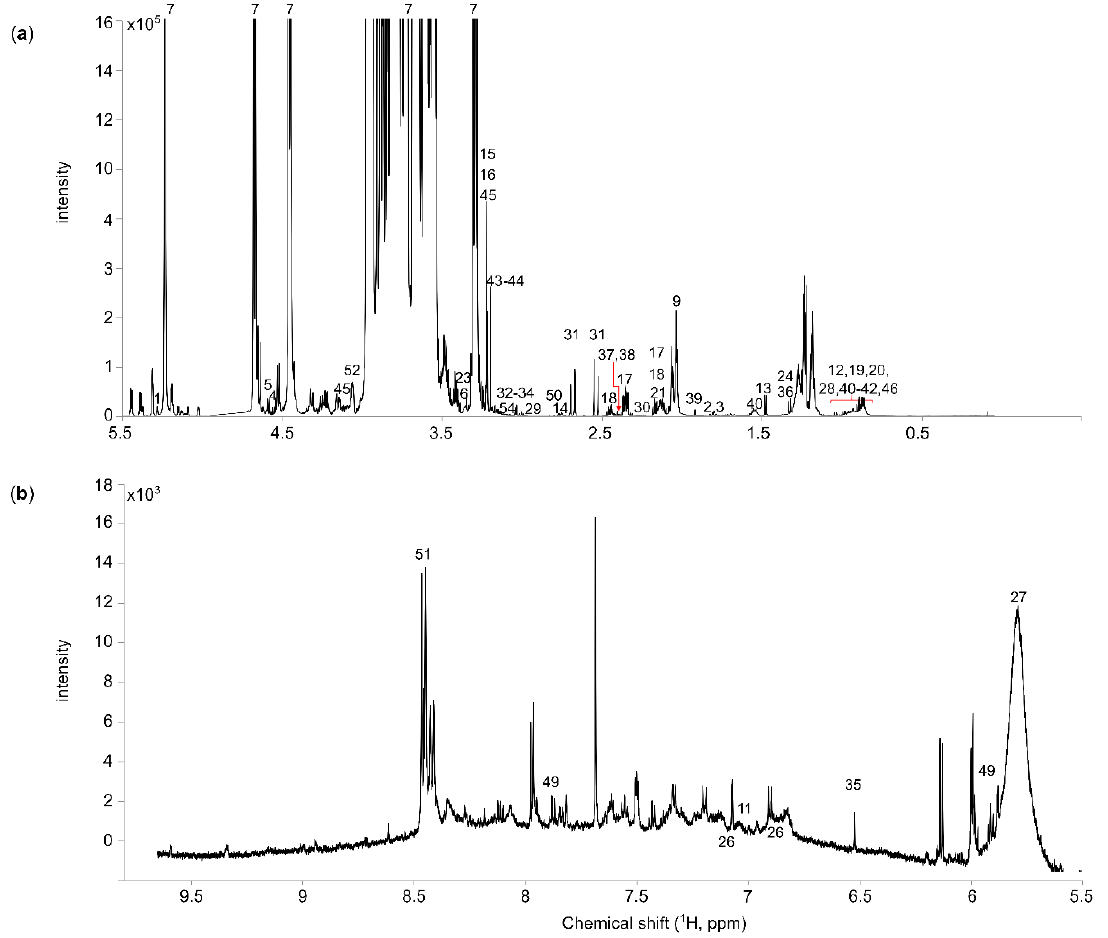
Figure 1. Median 1H NMR spectrum of human breast milk samples ( n = 130). ( a ) Aliphatic region 5.0–0 ppm; and ( b ) aromatic region 5.5–9.7